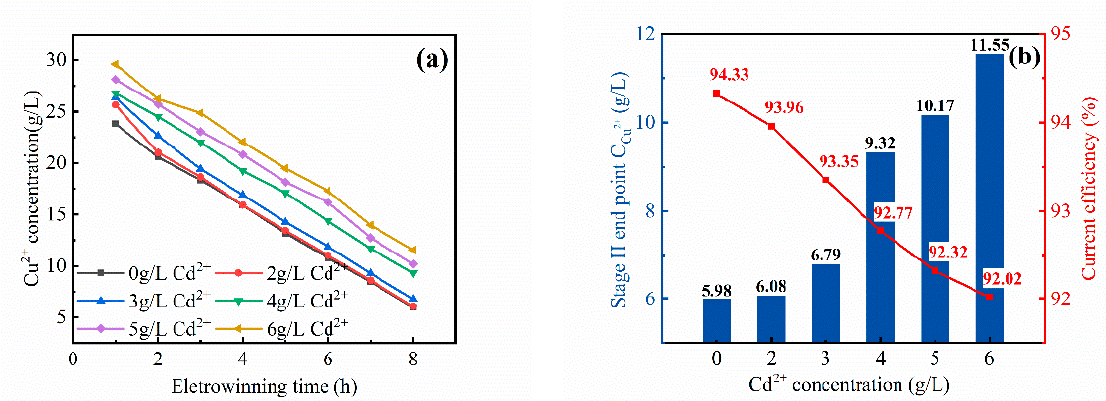
Figure 7. The curve of Cu concentration, endpoint content, and current efficiency in the second stage of the cyclone electrowinning process: ( a ) Cu concentration; ( b ) Endpoint content and current efficiency. Table 2. Copper purity of cathode with different Cd 2+ concentrations in the second stage. Metal El-